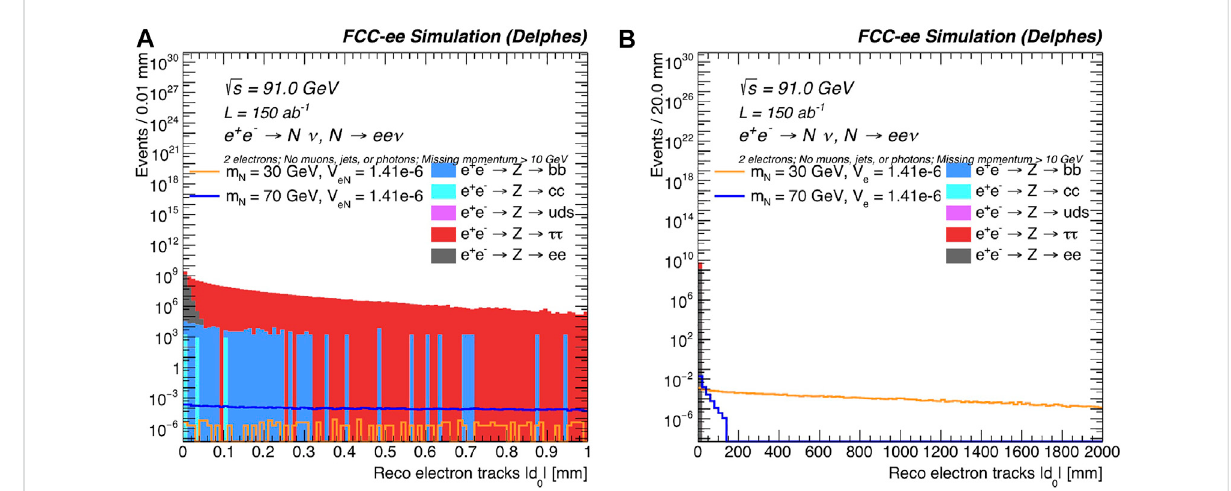
FIGURE 16 Thenormalized,reconstructed-levelabsolutevalueofthetransverseimpactparameter| d 0